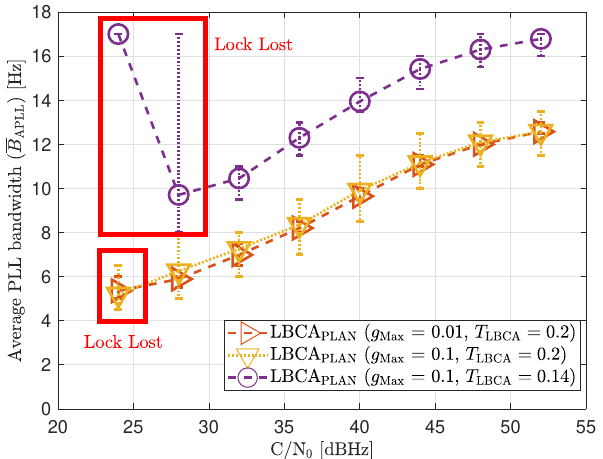
Figure 26. Average LBCA + PLAN PLL loop bandwidth of SV G4 tracking in static